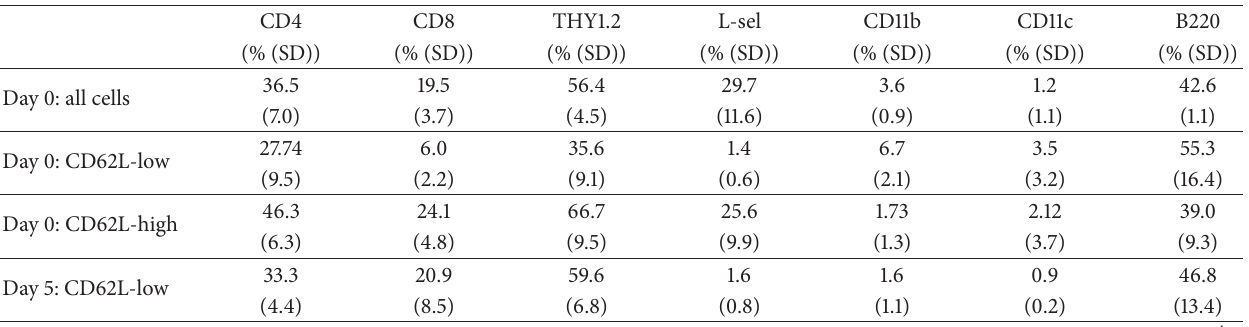
Table 1: FACS analysis of baseline 4T1 TDLNs and after culture activation of the L-selectin low